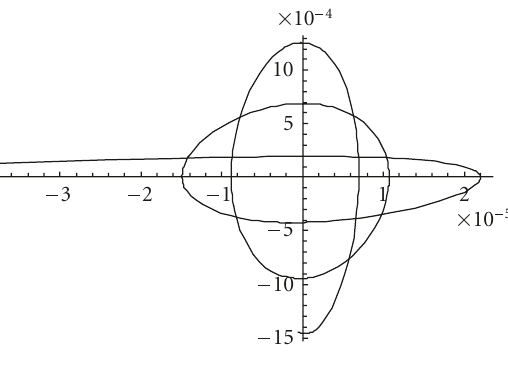
Figure 4.2. ( ρ 0 (cid:8) − 0 . 0001, ξ (cid:8) 0 .